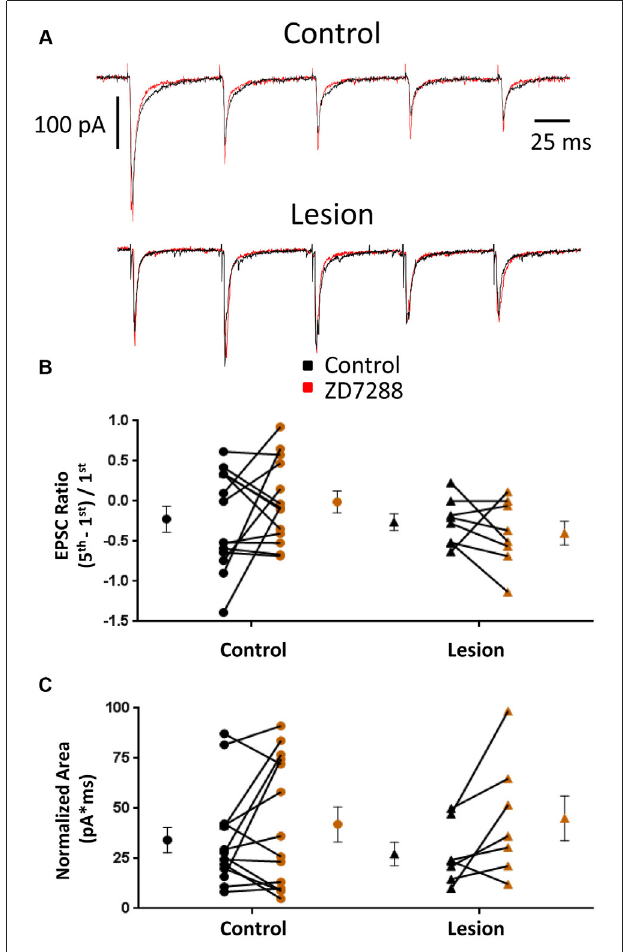
FIGURE 4 | EPSC properties in L5 fast spiking interneurons are not altered by HCN channel blockade. (A) Example traces of EPSCs evoked at 25 Hz in interneurons before (black) and after (red) ZD7288 application in control (top) and lesioned (bottom) animals. (B) HCN channel inhibition did not change EPSC ratios in control or freeze lesioned animals. No difference was seen in pre-drug ratios between control and freeze lesioned rats